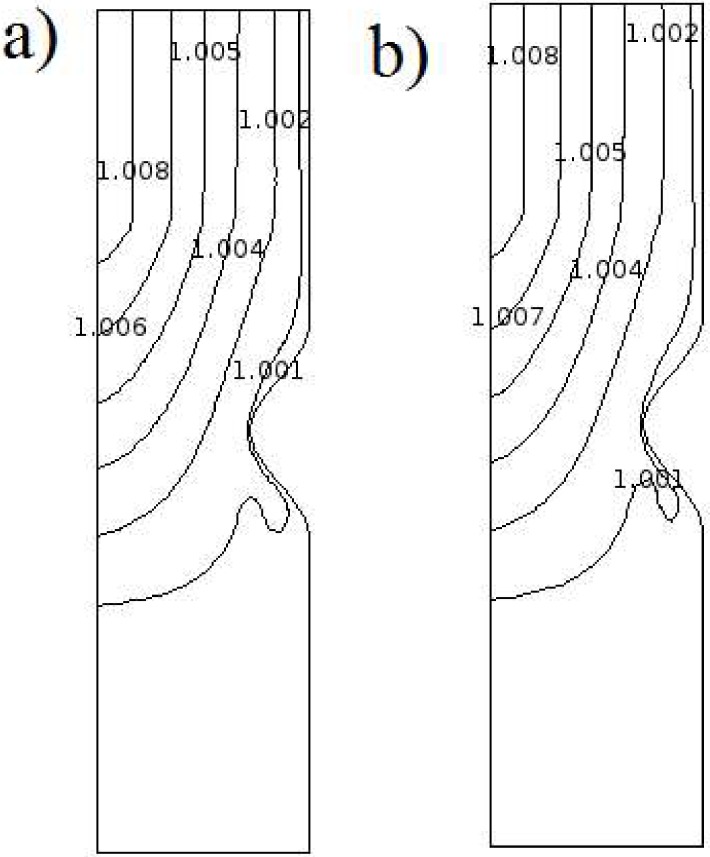
Temperature distribution for 28% stent ratio Qv = 0.001 and QJ = 1 a) t = 0.01T b) t = T.